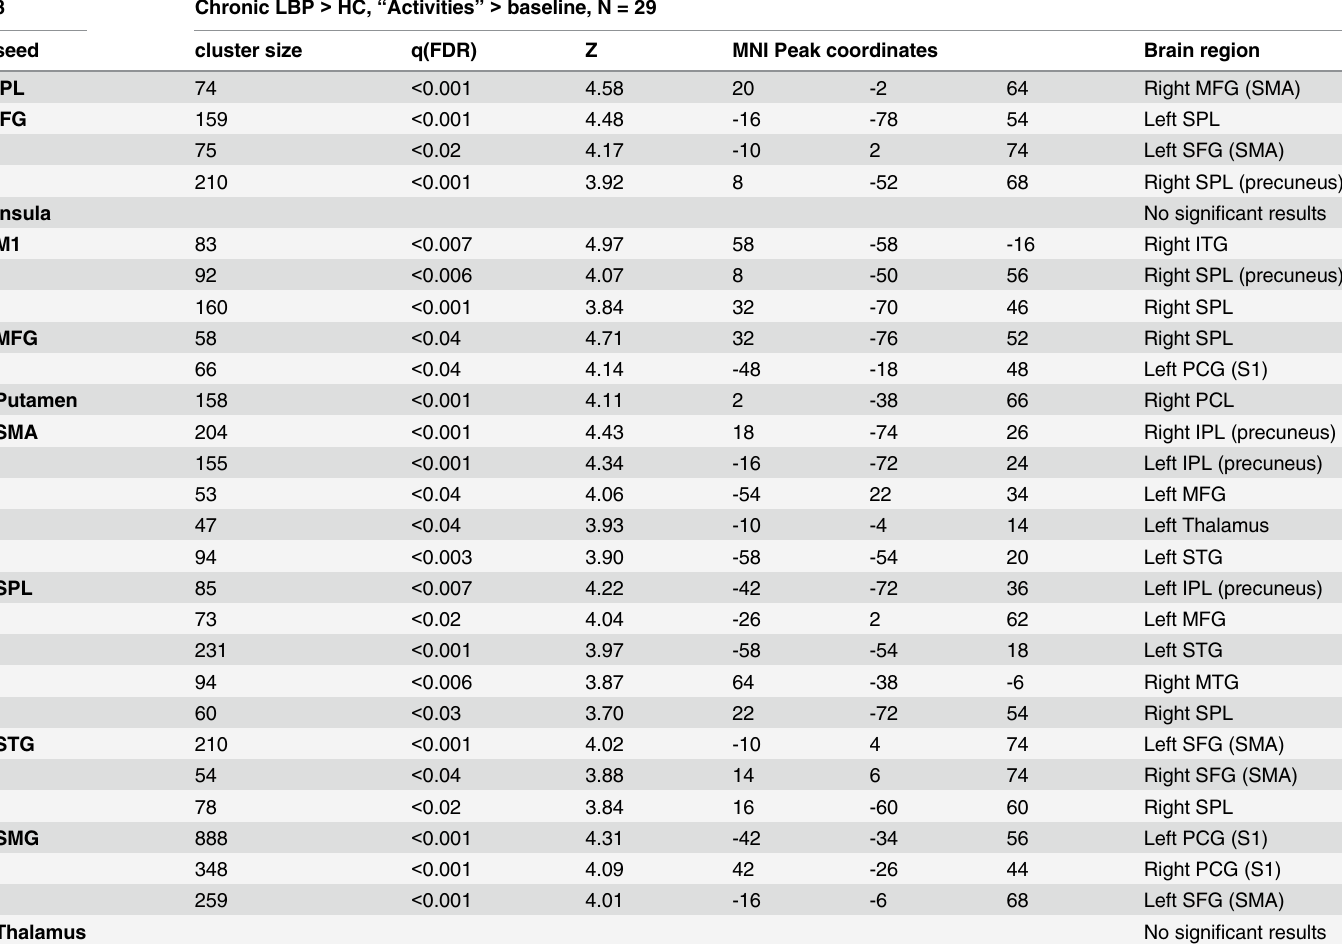
Table 3. Functional connectivity cluster maxima of the chronic Low Back Pain (LBP) group vs. healthy controls (HC), contrast activities of daily liv- ing ( “ Activities ” ). All results are false discovery rate corrected (FDR, q < 0.05). MNI = Montreal Neurological Institute, STG = superior temporal gyrus, ITG = inferior temporal gyrus, MTG = middle temporal gyrus, MFG = middle frontal gyrus, SFG = superior frontal gyrus, SMG = supramarginal gyrus, OL = occipital lobe, SPL = superior parietal lobule, IPL = inferior parietal lobule, PreCG = precentral gyrus, PCL = paracentral lobule, SMG = supramarginal gyrus.